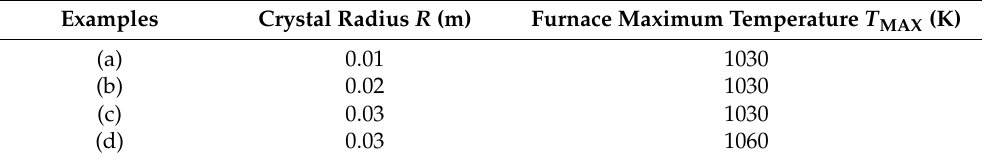
Table 4. The crystal radius and the furnace maximum